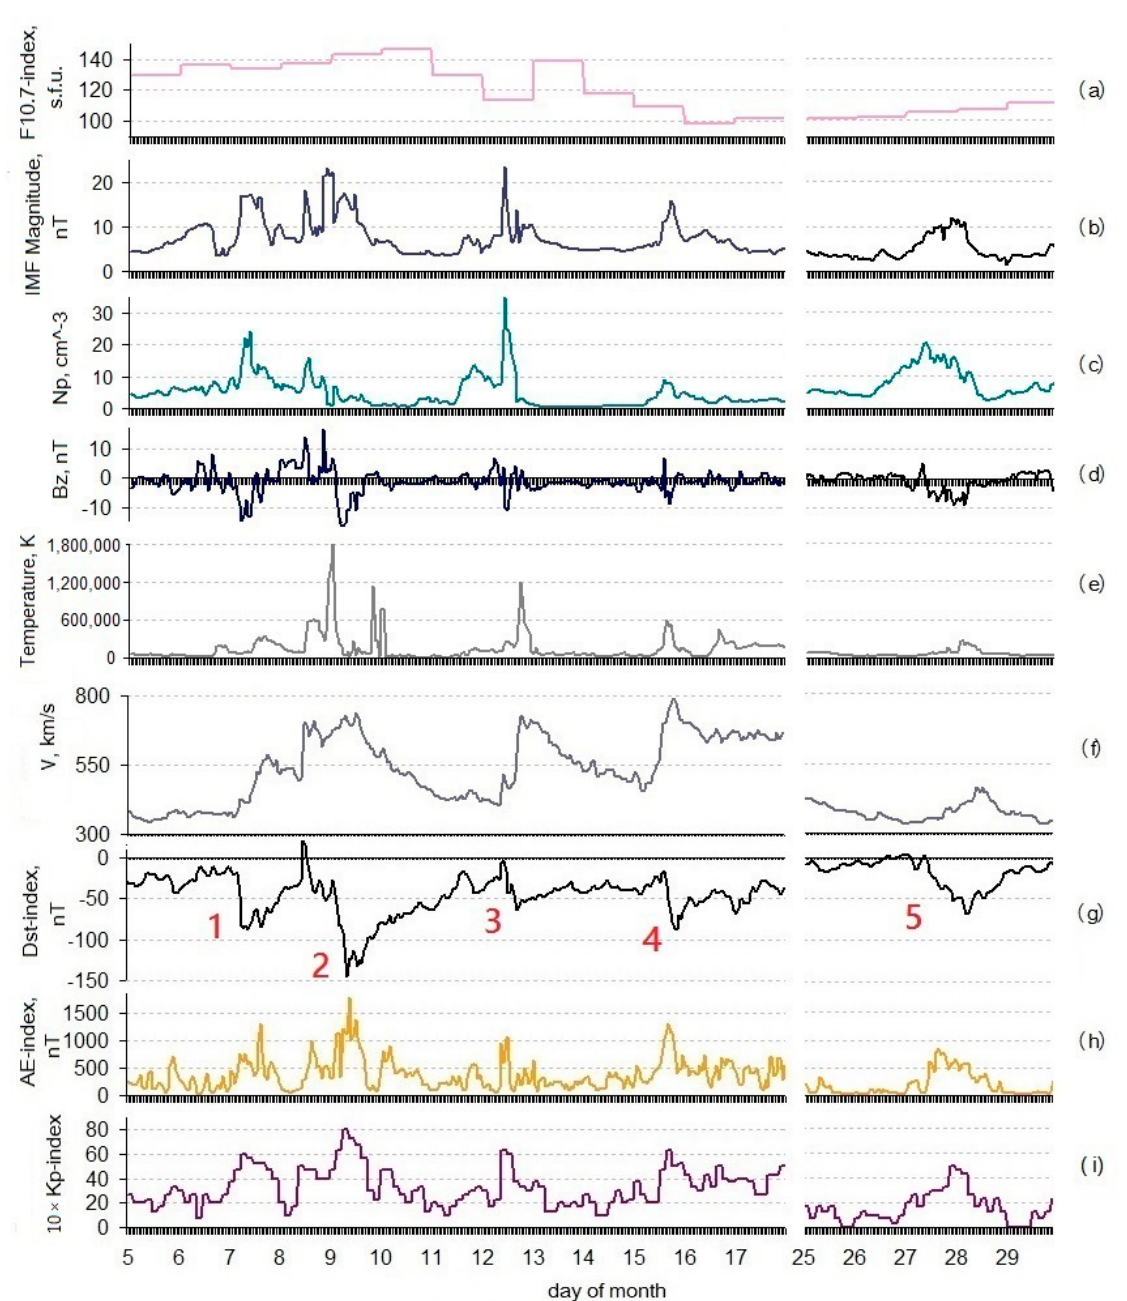
Figure 2. Space Weather parameter variations during 7–17 March and 25–29 March, 2012: ( a ) F10.7 index, ( b ) averaged magnitude of Interplanetary Magnetic Field (IMF), ( c ) proton density, ( d ) Bz-component of IMF, ( e ) solar wind proton temperature, ( f ) solar wind speed, ( g ) Dst-index, ( h ) AE-index and ( i ) Kp-index. Storm events are numbered 1–5.